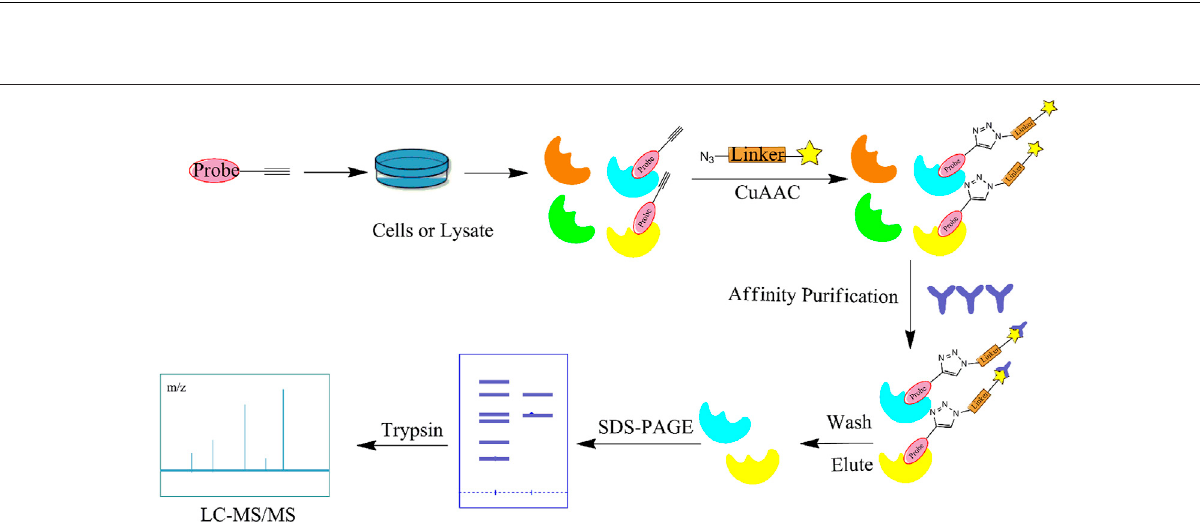
FIGURE 3 | General work fl ow of the activity-based protein pro fi ling (ABPP) method. The NP is fi rst probed for speci fi c af fi nity to adsorb the target protein. Af fi nity puri fi cation and elution are performed after contact with the cell lysate, and identi fi ed by sodium dodecyl sulfate (SDS)-PAGE and MS.